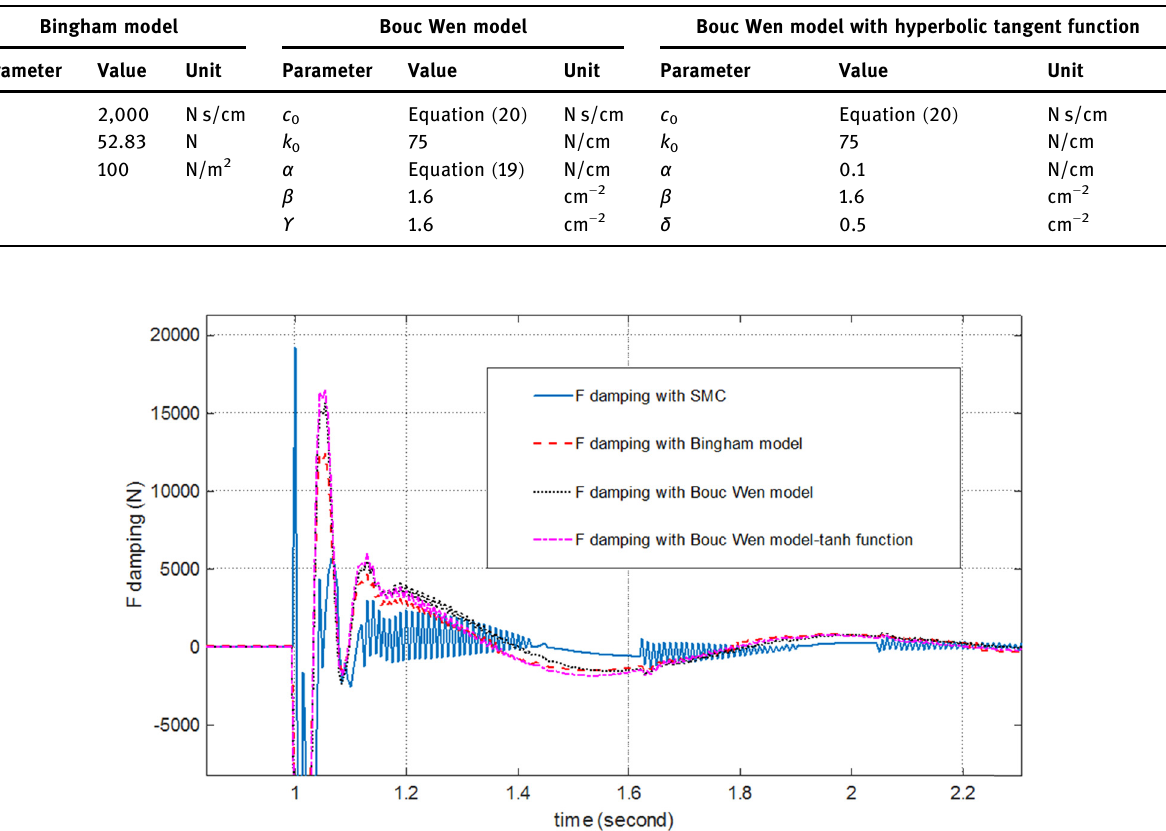
Figure 6: Damper force: SMC and MR damper models ( enlarged Figure 5 ( b )) .